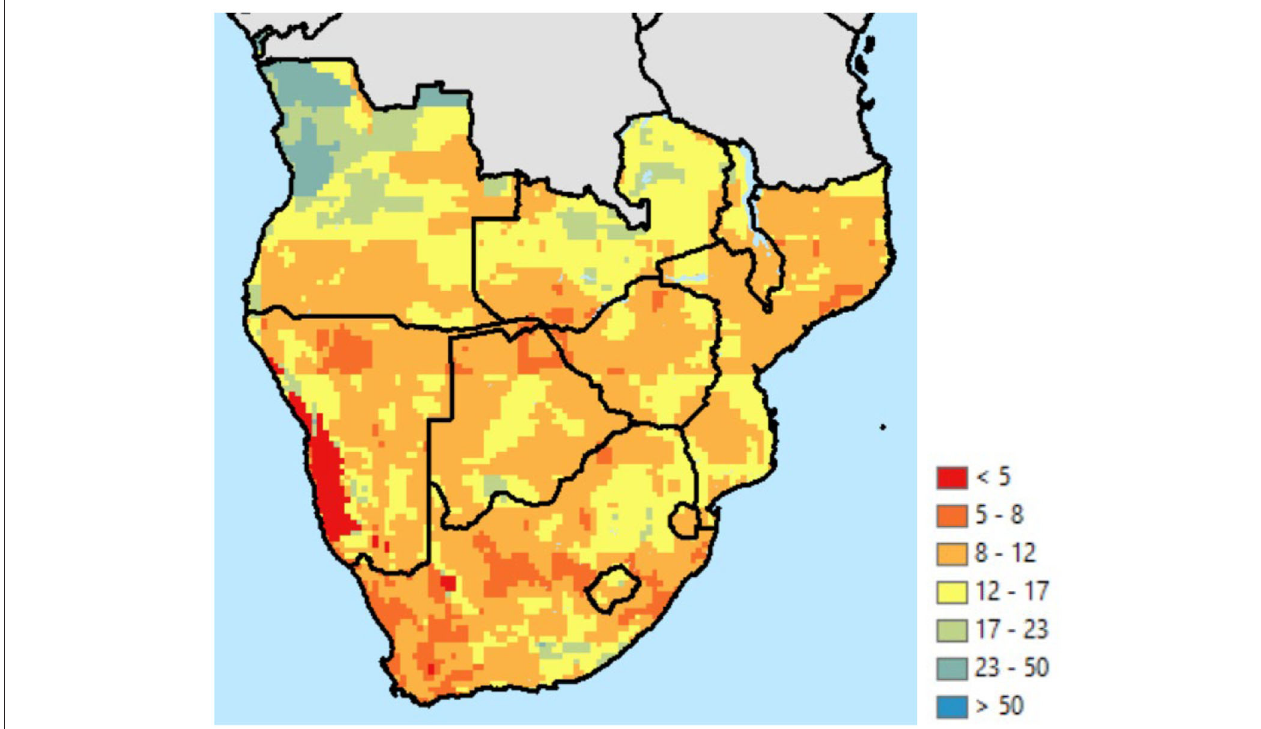
TABLE 3 | Change in frequency of very high and very low precipitation years for the wet 3 months of the year. Percent change in median precipitation relative to 2020s for “2C”